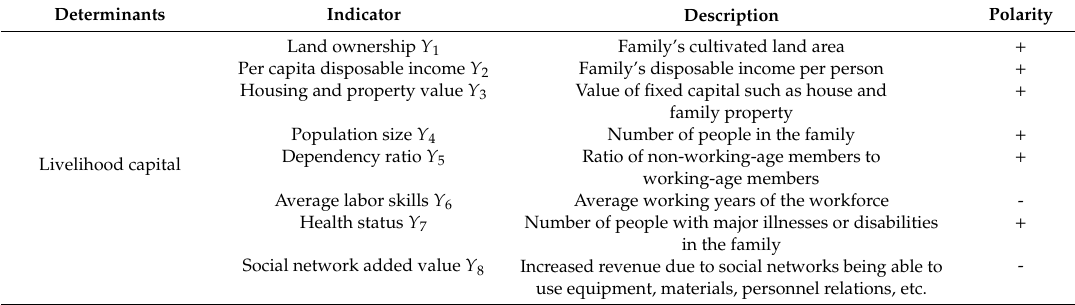
Table 1. Factors influencing livelihood